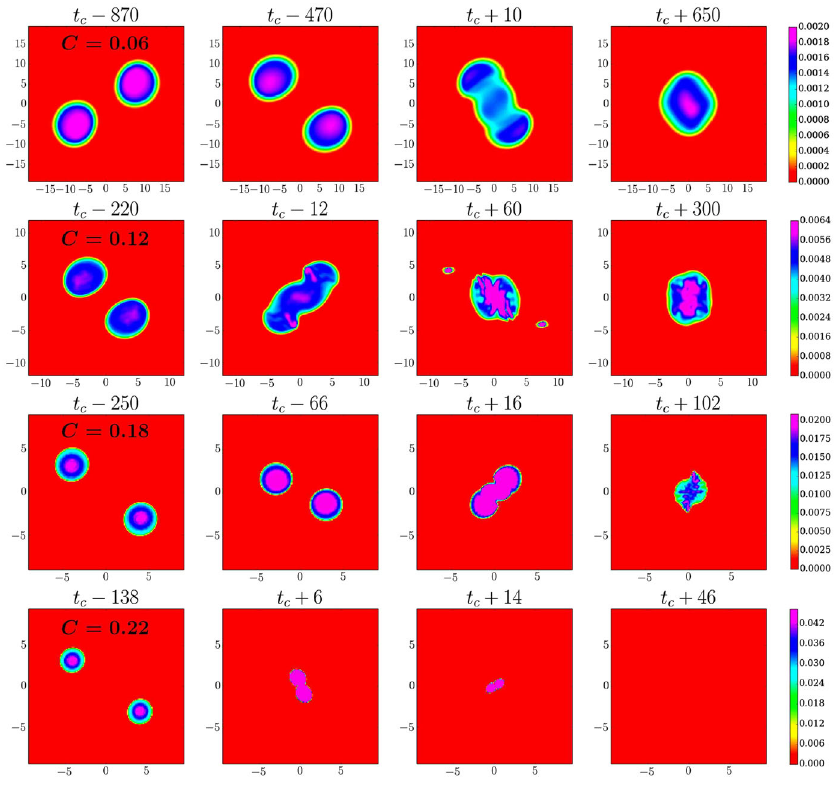
Fig. 27 Snapshots from the mergers of four different, equal mass, solitonic BS binaries with increasing compactnesses (from top row to bottom, each BS of the binary has compactness 0.06, 0.12, 0.18, and 0.22). Shown is the Noether charge density on the orbital plane before and after the time at which the stars fi rst make contact, t : 12 case ejects two blobs c . The most compact case collapses to a BH while the C ¼ 0 of scalar fi eld. Reproduced with permission from Palenzuela et al. (2017), copyright by the